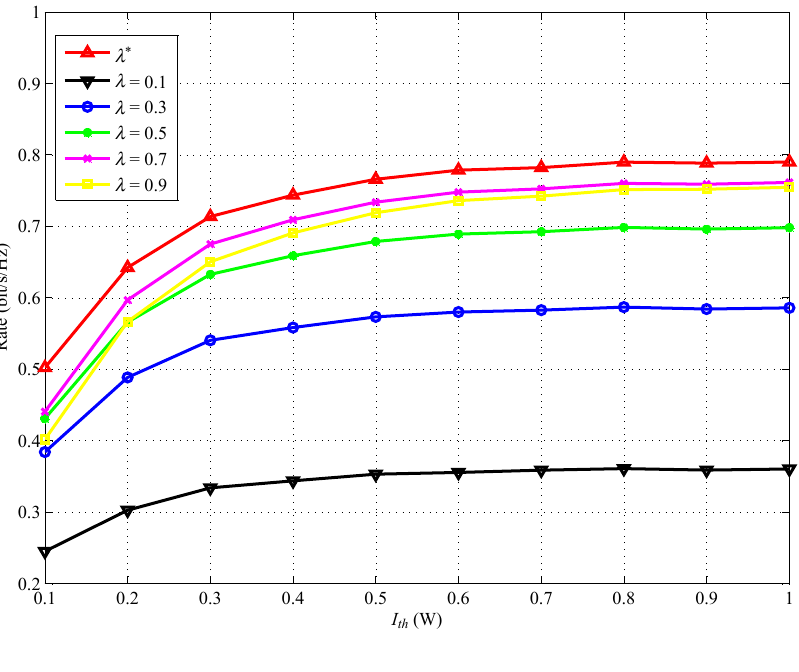
Figure 6. Achievable rate for various λ versus I th .